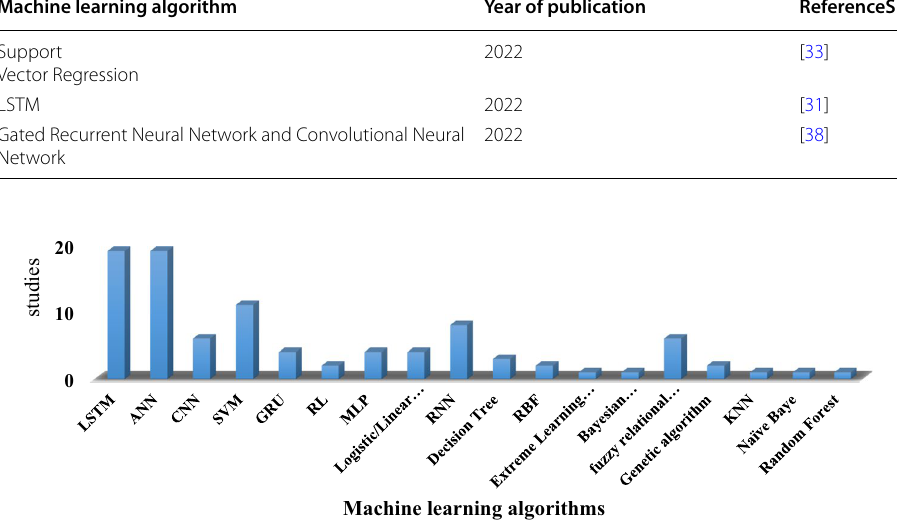
Fig. 4 Bar chart reporting the number of primary studies and the machine learning algorithm adopted in